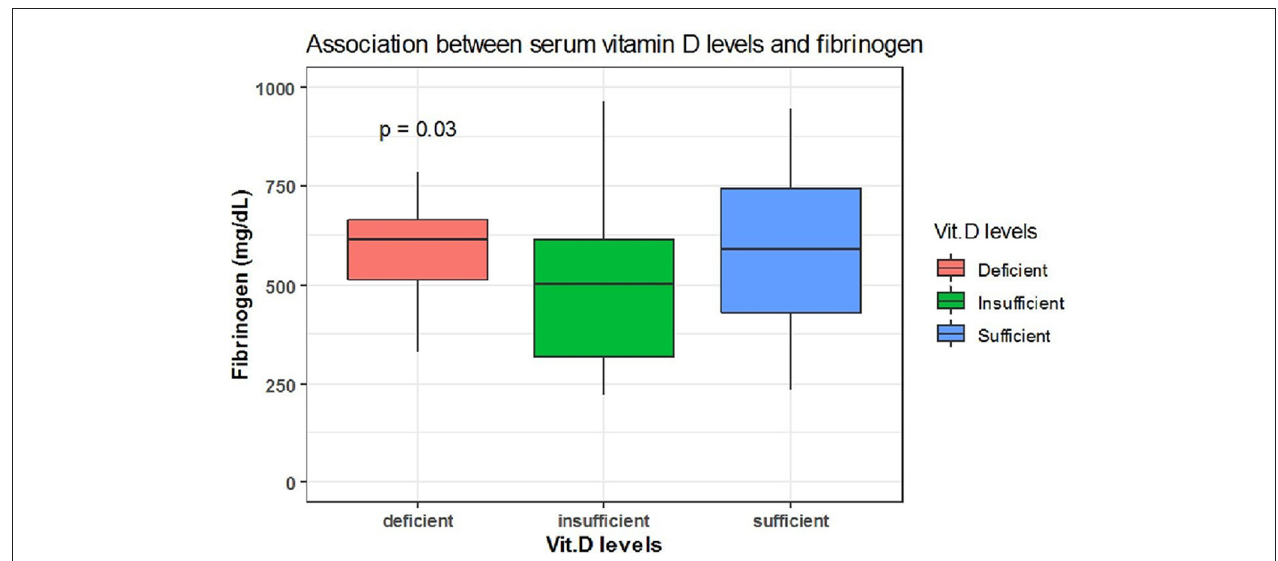
FIGURE 2 | The association between serum 25(OH)D levels (sufficient, insufficient, deficient) and fibrinogen (mg/dL).